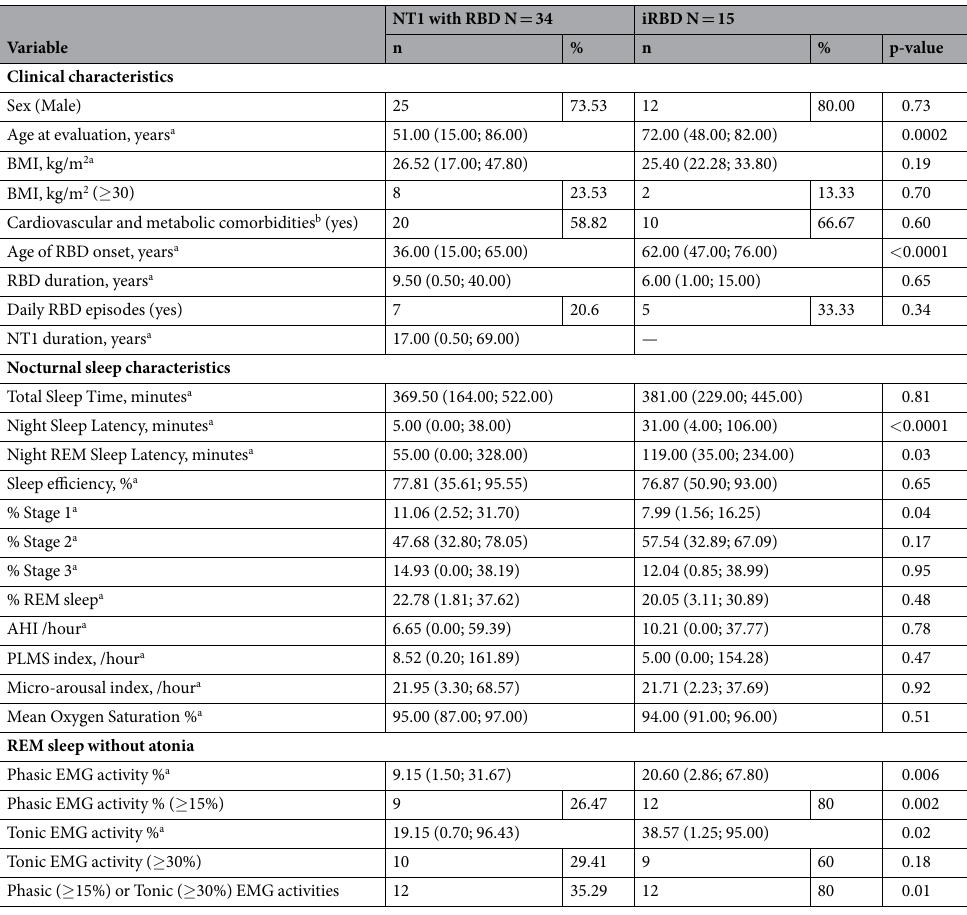
Table 1. Clinical and polysomnographic characteristics of patients with narcolepsy type 1 (NT1) and rapid eye movement sleep behavior disorder (RBD), and of patients with idiopathic RBD (iRBD). a Continuous variables are expressed as median (minimal value; maximal value). REM = rapid eye movement , BMI = body mass index , AHI = apnea hypopnea index , PLMS = periodic leg movement during sleep , EMG = electromyography , MSLT = multiple sleep latency test , SOREMPs = sleep onset REM periods . b Cardiovascular and metabolic comorbidities: Presence of diabetes type 2 or use of antidiabetic drugs, cardiac disorders (personal history of coronary artery disease, chronic heart failure, arrhythmia), hypertension or treatment with antihypertensive drugs, dyslipidemia or treatment with lipid-lowering drugs, or